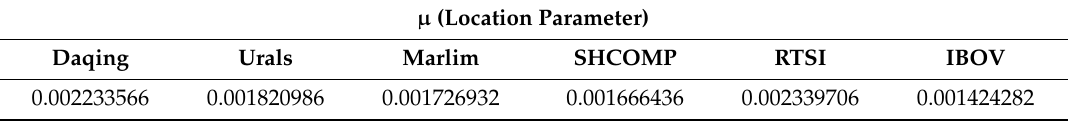
Table A6. MNIG Location parameter µ for Vector 2: Daqing, Urals, Marlim, SHCOMP, RTSI,